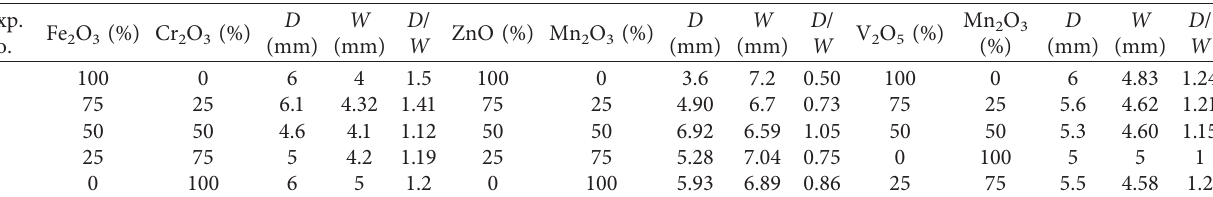
Table 6: Different compositions of fluxes, depth of D and D / W